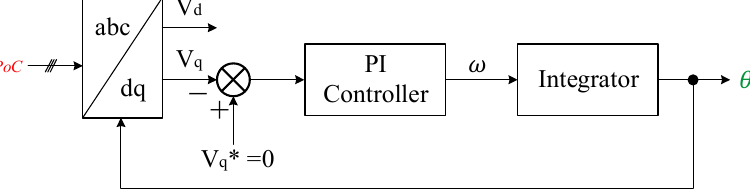
Figure 9. Schematic of a simple PLL controller.